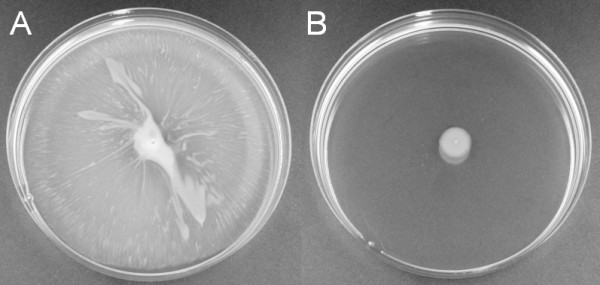
Swarming of A. baumannii ATCC 17978. A. baumannii colony material was spotted on Luria-Bertani medium containing 0.25% agar. Swarming motility (A) is visible as the channel-like growth around the dense white colony material. The absence of halo growth around the colony (B) indicates lack of swarming motility of A. baumannii when available iron is limited.